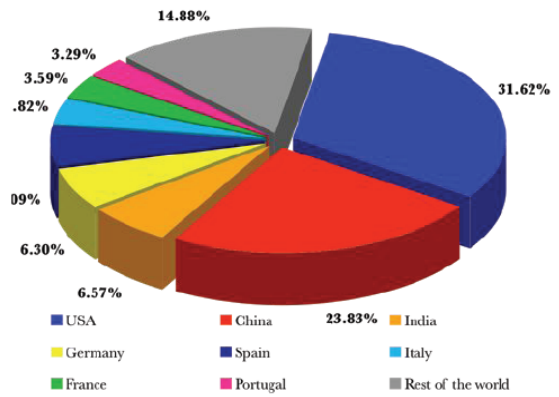
Figure 42. Regional shares of added capacity in 2008 (after [51]). © 2008 WWEA, reproduced with